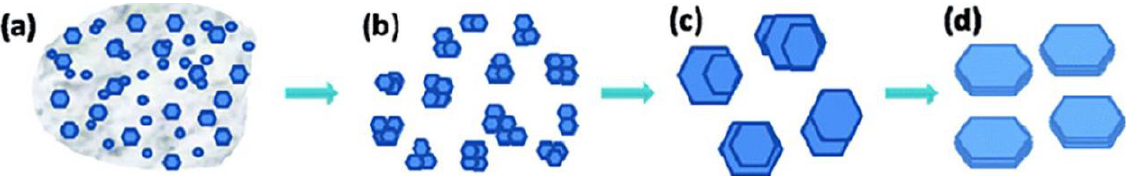
Figure 2. Representation of α -ZrP crystal formation. ( a ) Precipitation of nanocrystals and amorphous particles from solution. ( b ) Lattice orientation of nanocrystals with formation of secondary clusters. ( c ) Growth of microcrystals from secondary clusters. ( d ) Formation of homogeneous and regular crystals by dissolving poorly ordered areas and subsequent re-precipitation. Reprinted with permission from reference [20], License number: 1173274-1.